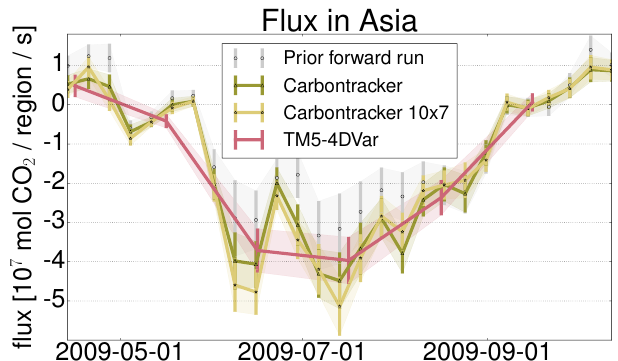
Figure 11. CO 2 surface fluxes during summer 2009 in Asia. The prior forward run shows the prior fluxes aggregated to the bin size of the weekly CarbonTracker scaling